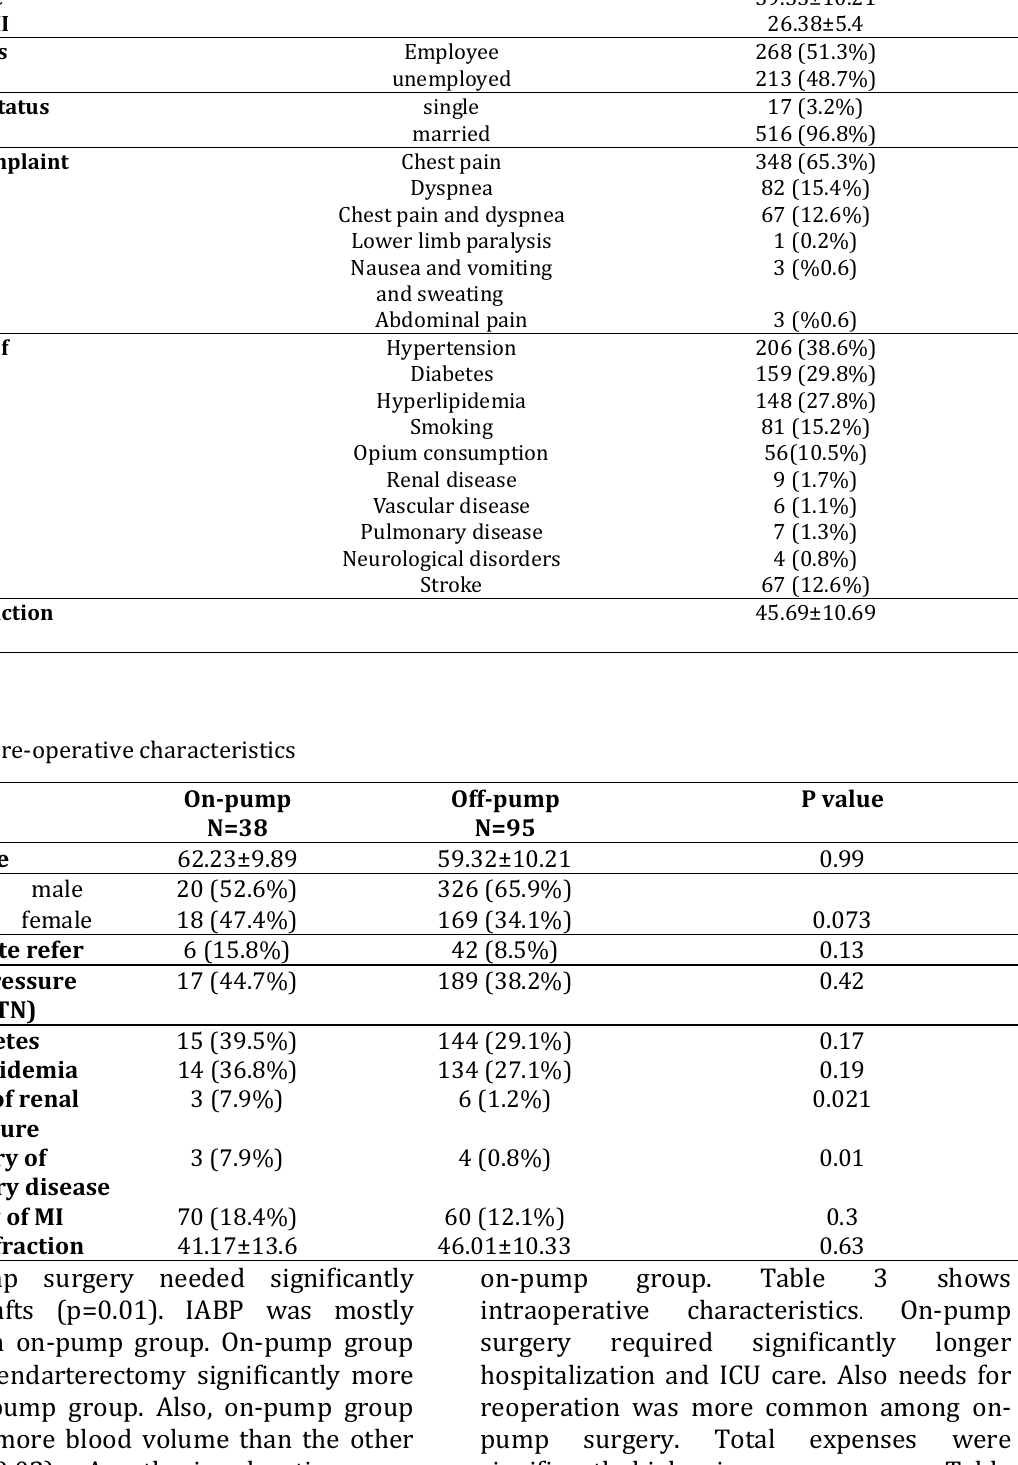
characteristics .